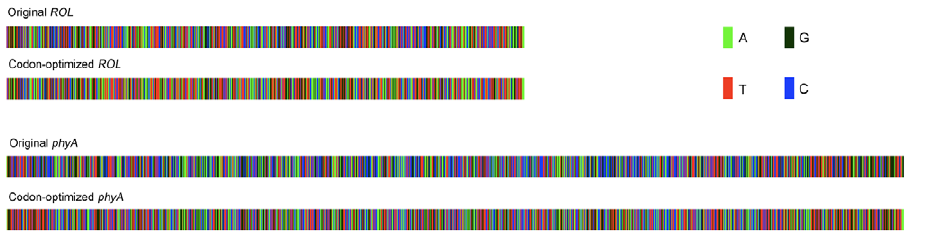
Figure 2. Sequence comparison between the original and the codon optimized genes. Dots in figure represent the same nucleotides between original and optimized genes. (A) Original and optimized ROL gene, and (B) Original and optimized phyA gene.